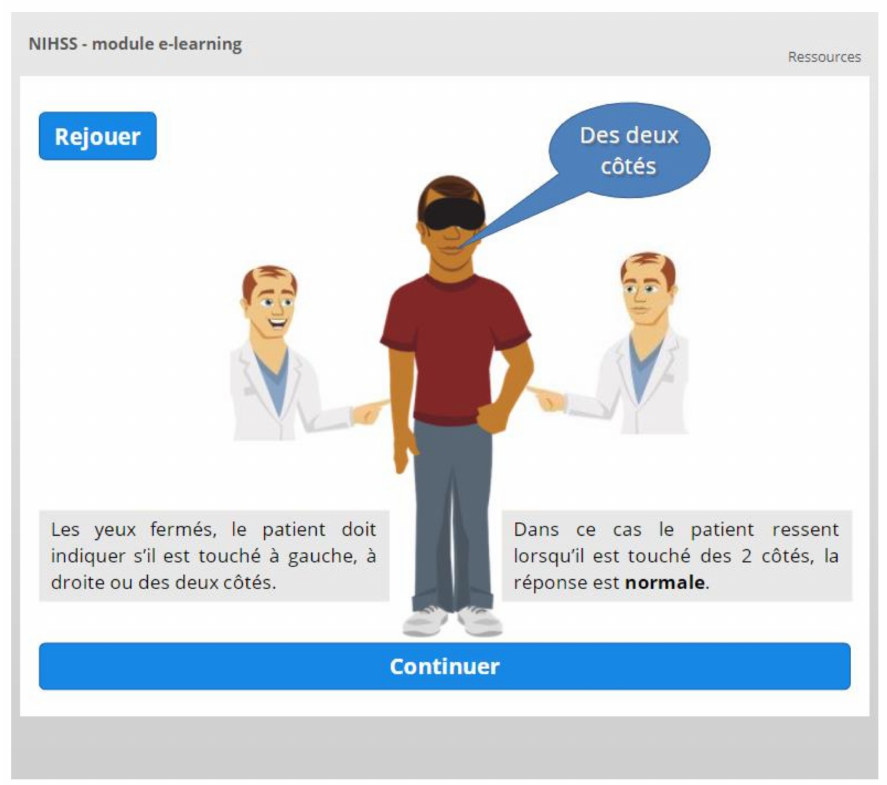
Figure 6. Interactive slide used to remind or teach the concept of